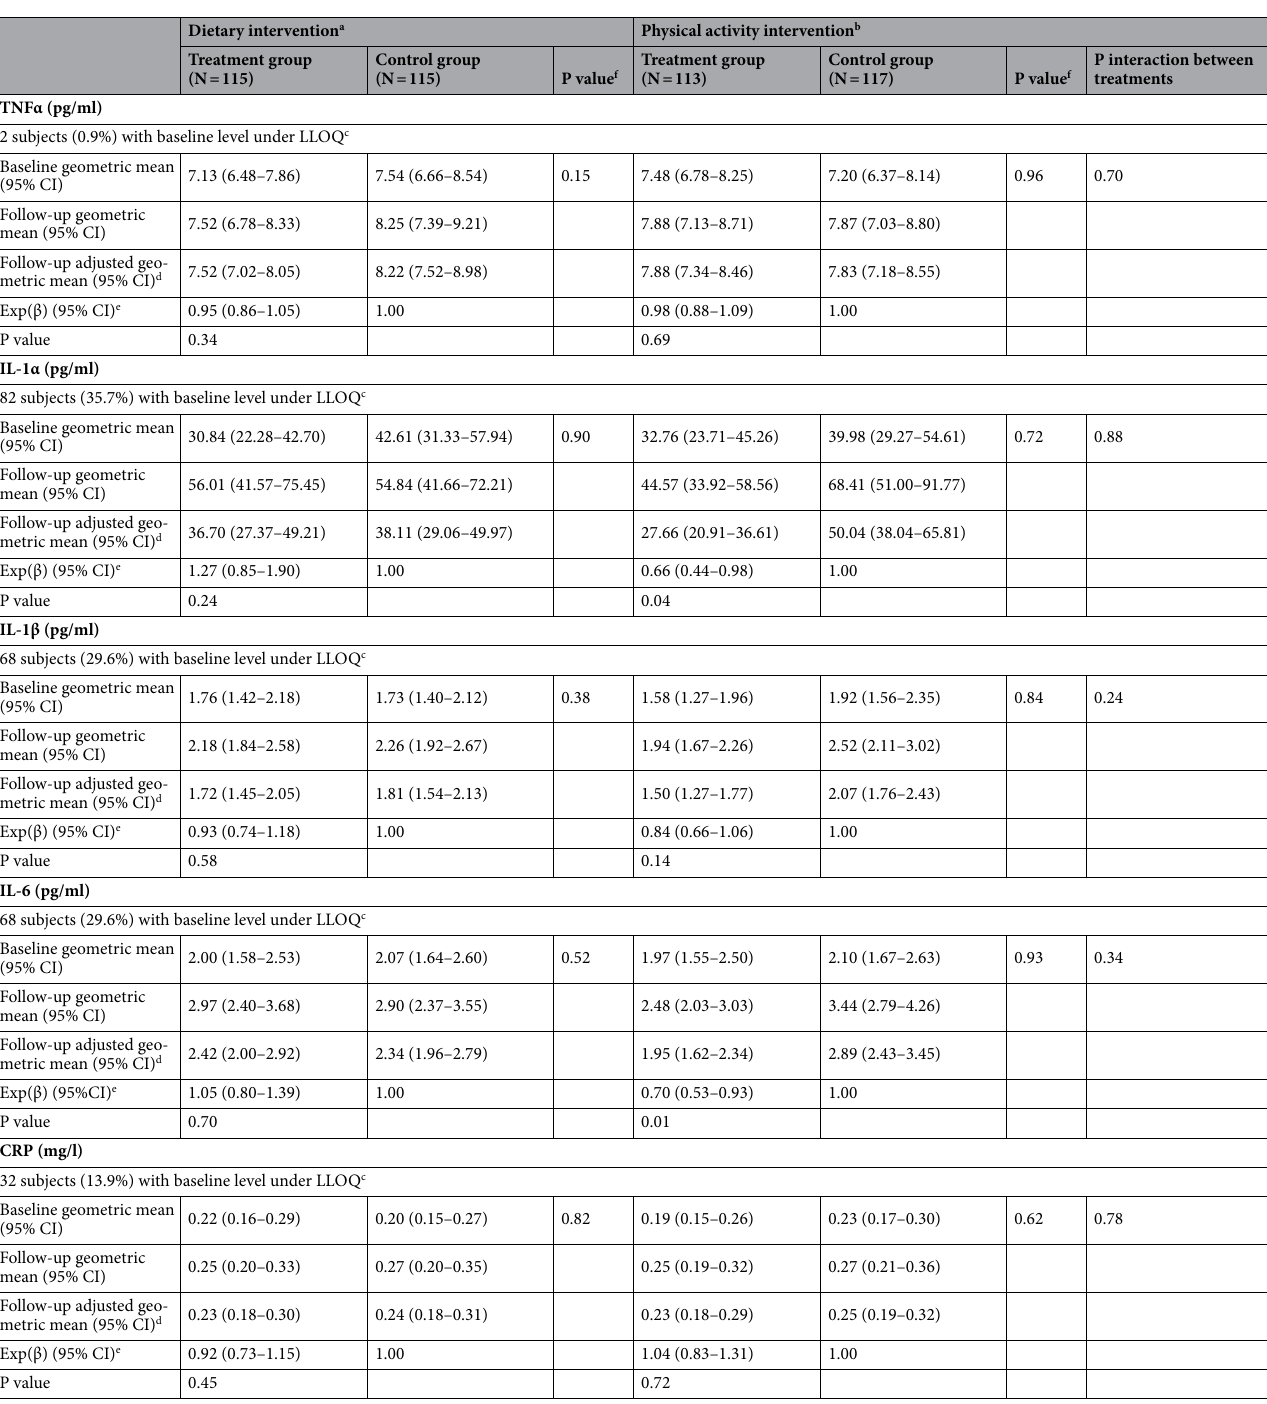
Table 2. Analysis according to treatment group compared with control group. The DAMA (Diet, Exercise and Mammography) trial. a Arms #1 + #3 versus arms #2 + #4. b Arms #2 + #3 versus arms #1 + #4. c LLOQ = lower limit of quantification. Plasma cytokines concentrations falling below the LLOQ were replaced with LLOQ/2. d Adjusted for log-transformed cytokine level at baseline and randomisation block variables (age and BMI). e Tobit model adjusted for baseline log-transformed cytokine level and randomisation block variables (age and BMI). f P values according to treatments were calculated from